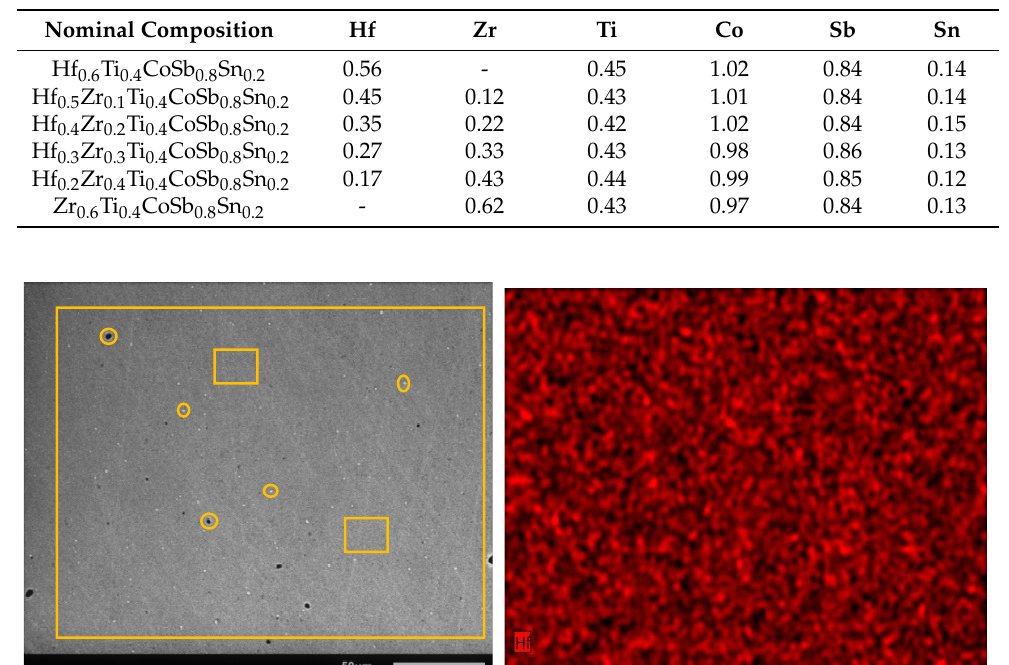
Table 2. Nominal and chemical composition of hot-pressed Hf 0.6-x Zr x Ti 0.4 CoSb 0.8 Sn 0.2 samples as determined by EDS.